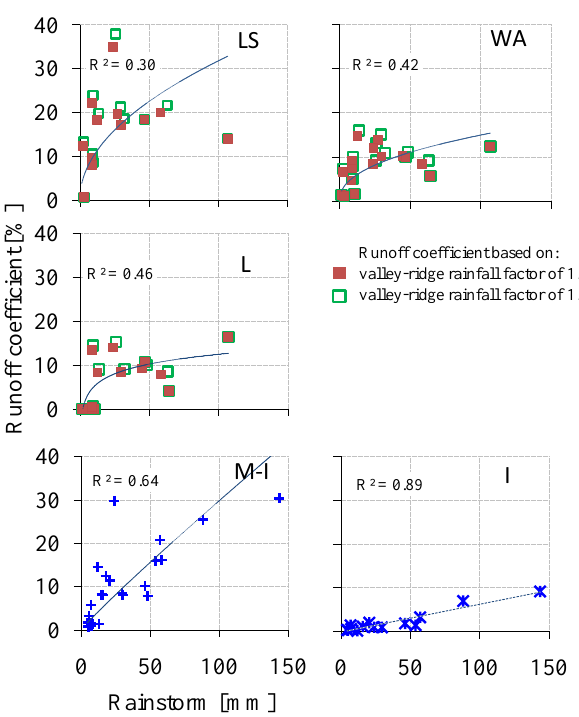
Fig. 6. Complete record of runoff percentages for the hydrometric stations in Ramallah (WA, LS and L) and Modiin (I and M). Sta- tion J (Modiin) is not included as only one storm generated runoff during the investigated